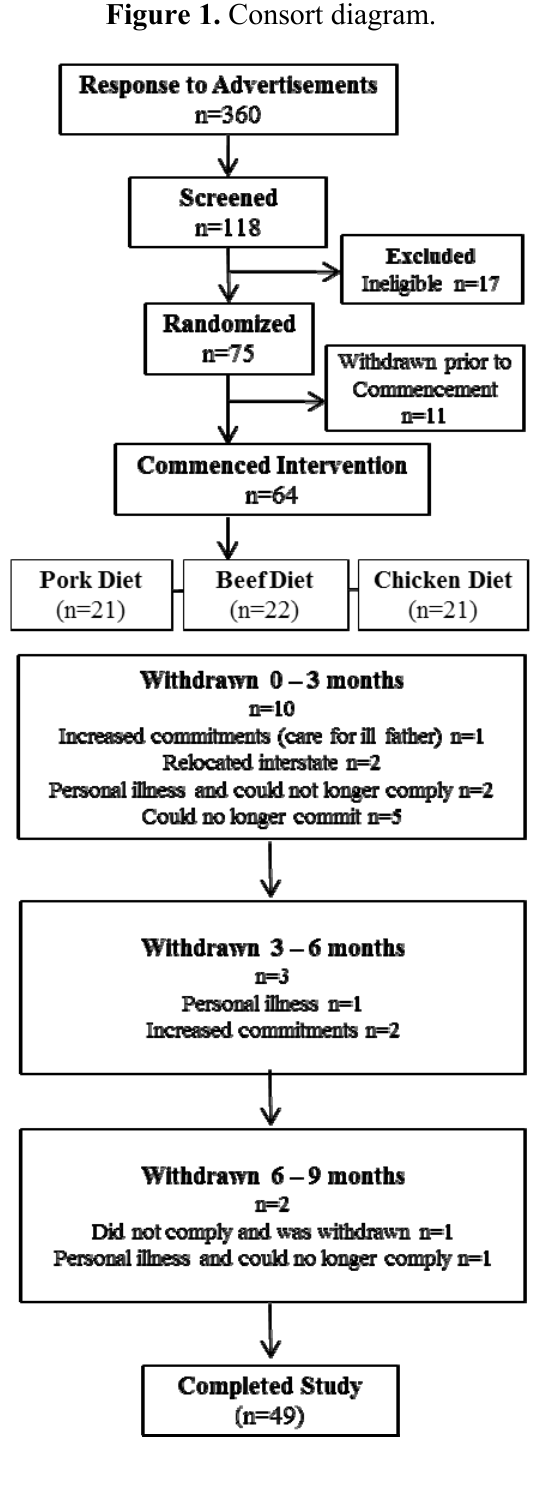
Figure 1. Consort